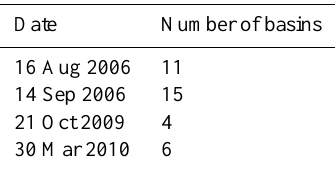
Fig. 5. Results of hydrological nowcasting framework for the Scrivia basin closed at Mereta (Area = 282km 2 ) . The event on 16 Aug 2006 is shown. The thick grey vertical line represents the time of the last available observed field for each nowcasted scenario. The thin grey vertical line represents the end of nowcasting. The Run No Nowcasting is the discharge obtained feeding the rainfall-runoff model with observed rainfall only. Number of involved modelled basins for each event. Basins where both the peak flow of the reference hydrograph and the maximum of the peaks of the discharge scenarios are under a fixed threshold have been